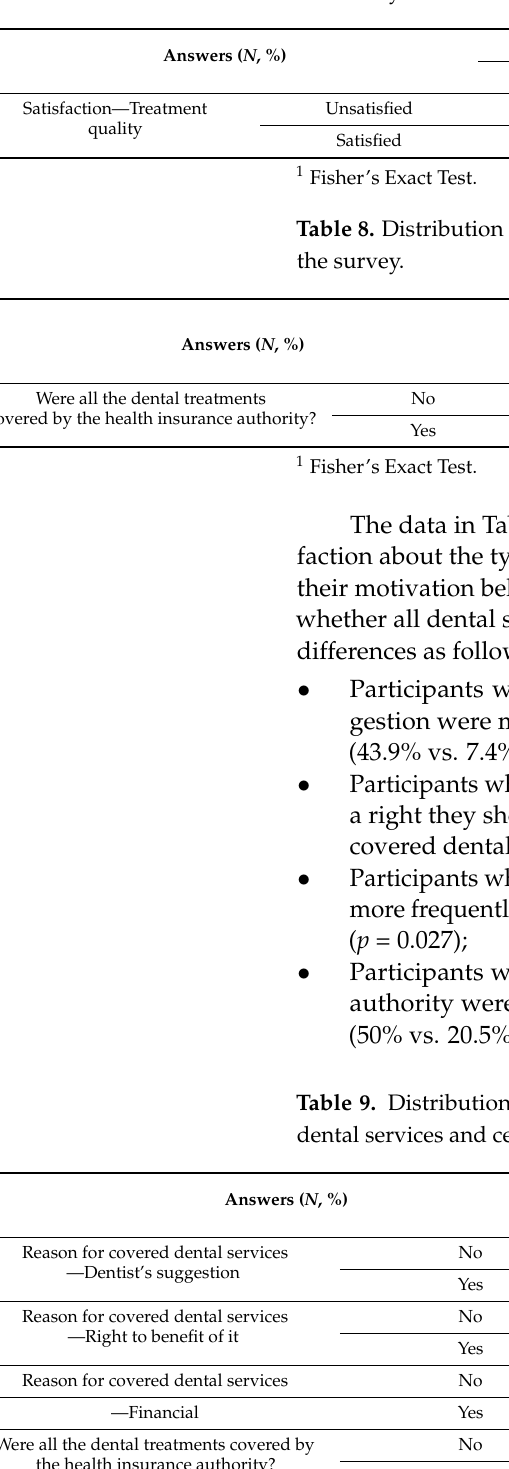
Table 7. Distribution of the participants according to frequency of dentist visit and certain answers in the survey.